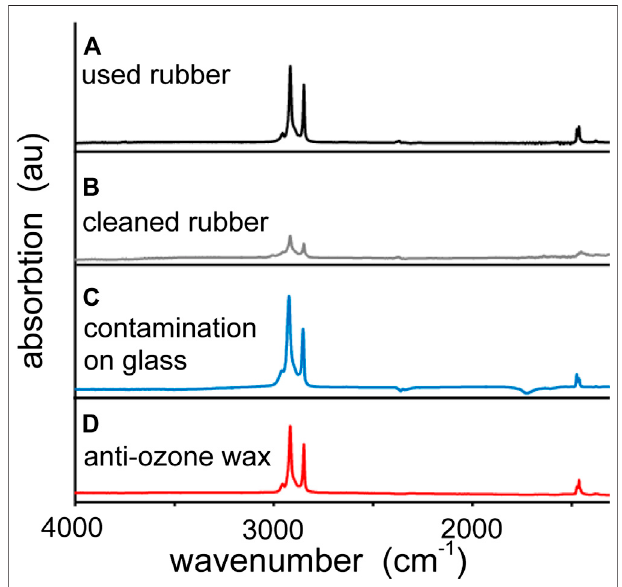
FIGURE 7 | Surface contamination of the rubber compound A. The infrared absorption spectra from (A) a not-cleaned rubber surface, (B) a rubbersurface cleaned withacetone, (C) the contamination fi lm lefton aglass surface after sliding of compound A and (D) anti-ozone wax.